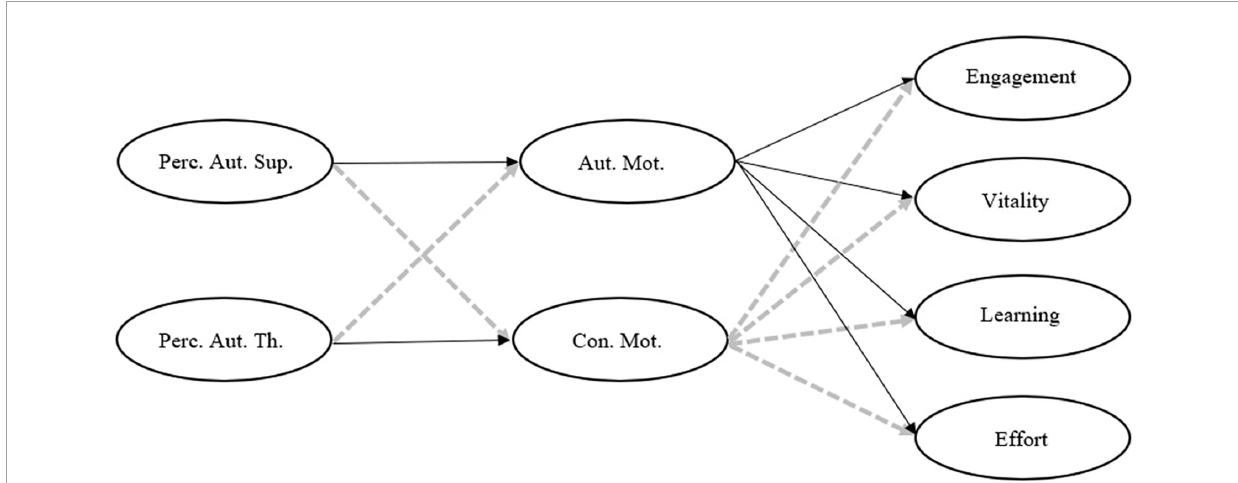
FIGURE1 A process model of the hypothesized linkage between our study variables. Solid lines indicate positive relationship, dotted lines indicate negative relationship. Perc. Aut. Sup., Perceived autonomy support; Perc. Aut. Th., Perceived autonomy thwarting; Aut. Mot., Autonomous motivation; Con. Mot., controlled motivation.